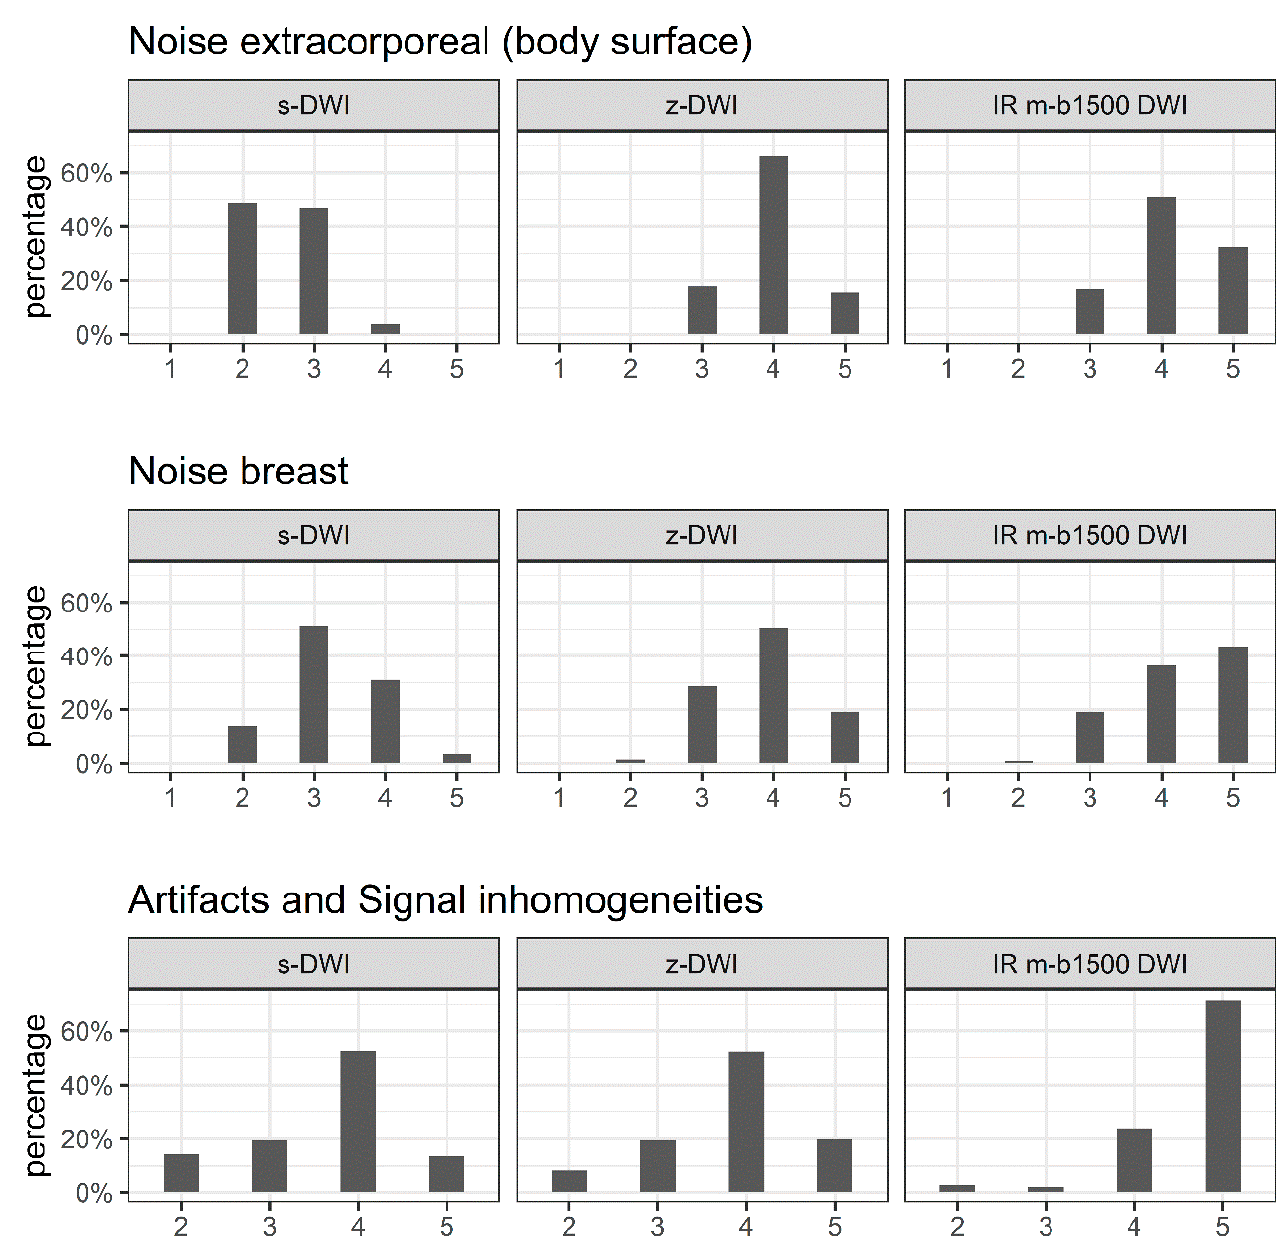
Figure 5. Distribution of ratings for extracorporeal noise, noise in the breast, and artifacts scored on a Likert scale (1 = poor; 2 = fair; 3 = good; 4 = very good; 5 = excellent). We tested for significant differences in Likert scores between the three sequences (single-shot echo-planar diffusion-weighted imaging (DWI) (s-DWI)), zoomed DWI with spectral-attenuated inversion-recovery fat saturation (z-DWI), and improved inversion-recovery fat-saturation DWI (IR m-b1500 DWI) for each variable. Extracorporeal noise: p < 0.001 for s-DWI vs. z-DWI, s-DWI vs. IR m-b1500 DWI, and z-DWI vs. IR m-b1500 DWI. Noise in the breast: p < 0.001 for s-DWI vs. z-DWI, s-DWI vs. IR m-b1500 DWI, and z-DWI vs. IR m-b1500 DWI. Artifacts: p = 0.024 for s-DWI vs. z-DWI, p < 0.001 for s-DWI vs. IR m-b1500 DWI and z-DWI vs. IR m-b1500 DWI.